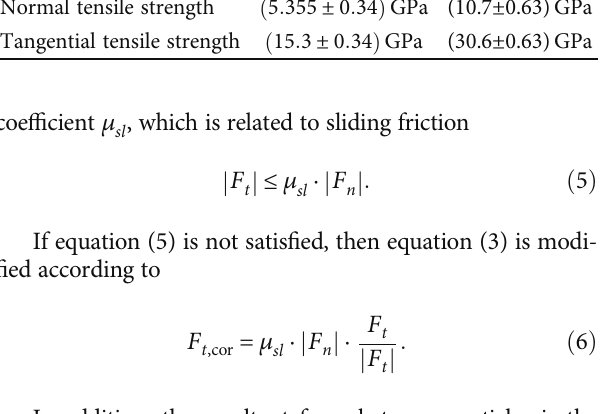
Figure 6: Taking the homogeneous slate model as the specimen, the schematic diagram of the relationship between micromodulus and macromodulus. Table 1: Solid bond element parameters of matrix and bedding. Solid bond